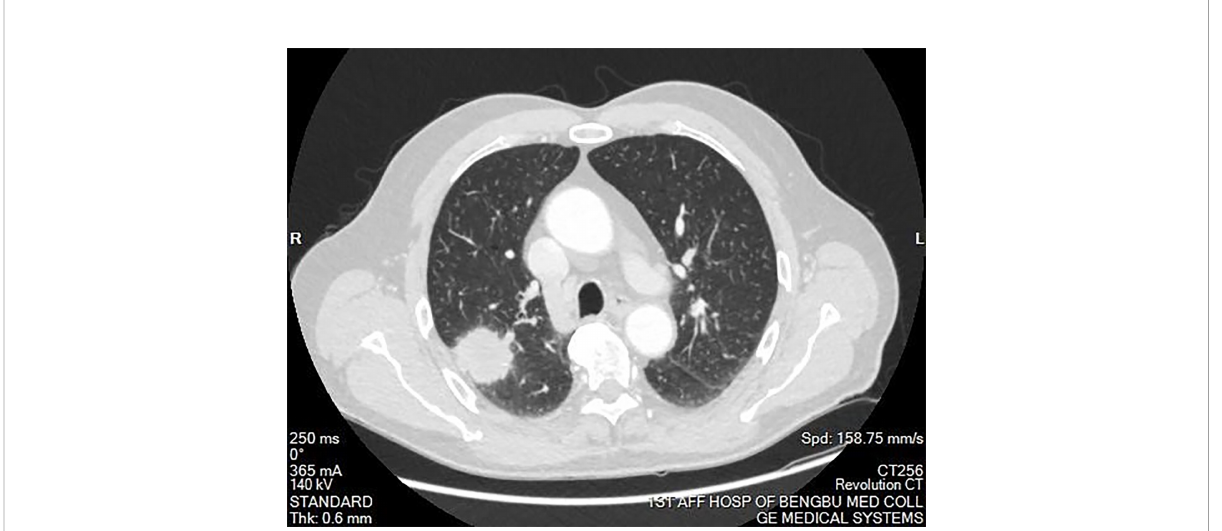
FIGURE 1 Computed tomography of the chest showing a mass in the right upper lobe of the lung. The mass was approximately 4cm in diameter. Burrs were present on the edge of the mass. A portion of the mass was connected to the pleura. The mass had uneven enhancement after the enhancement scan.